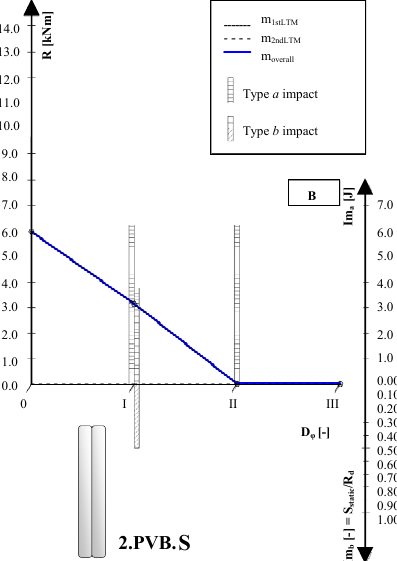
Figure 4: Element Safety Diagram for double layer, PVB-laminated, heat strengthened glass beam.